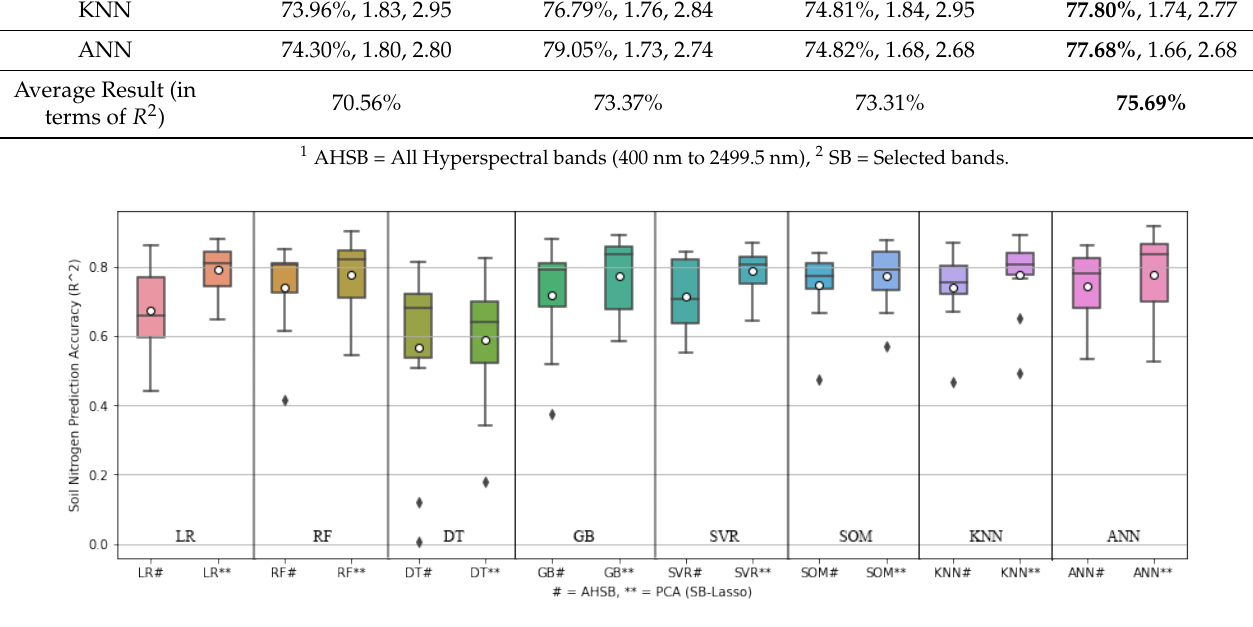
Figure 13. Box-plot of different ML approaches for predicting nitrogen